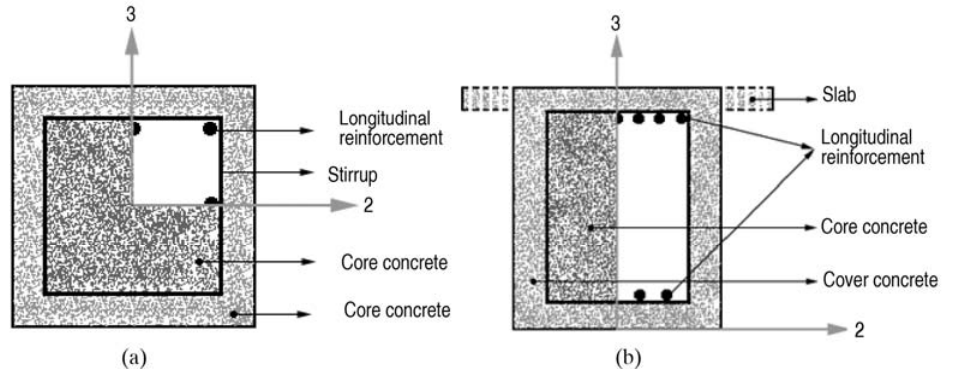
Fig. 1. Adopted R/C (a), T-section and (b) Rectangular section